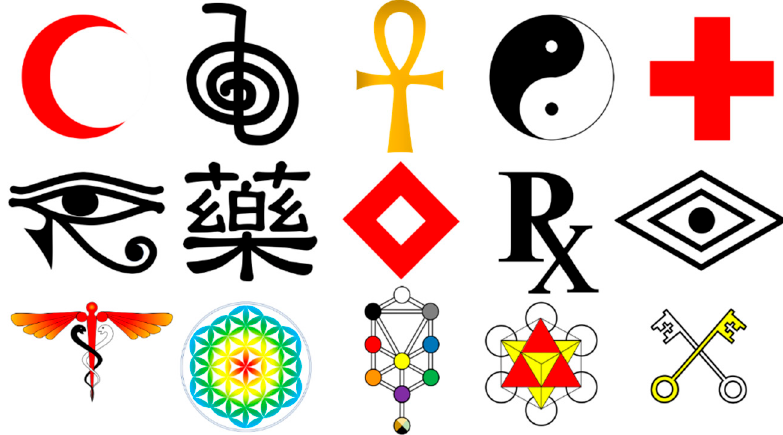
Figure 1. Symbols of health, medicine, and life in several cultures.